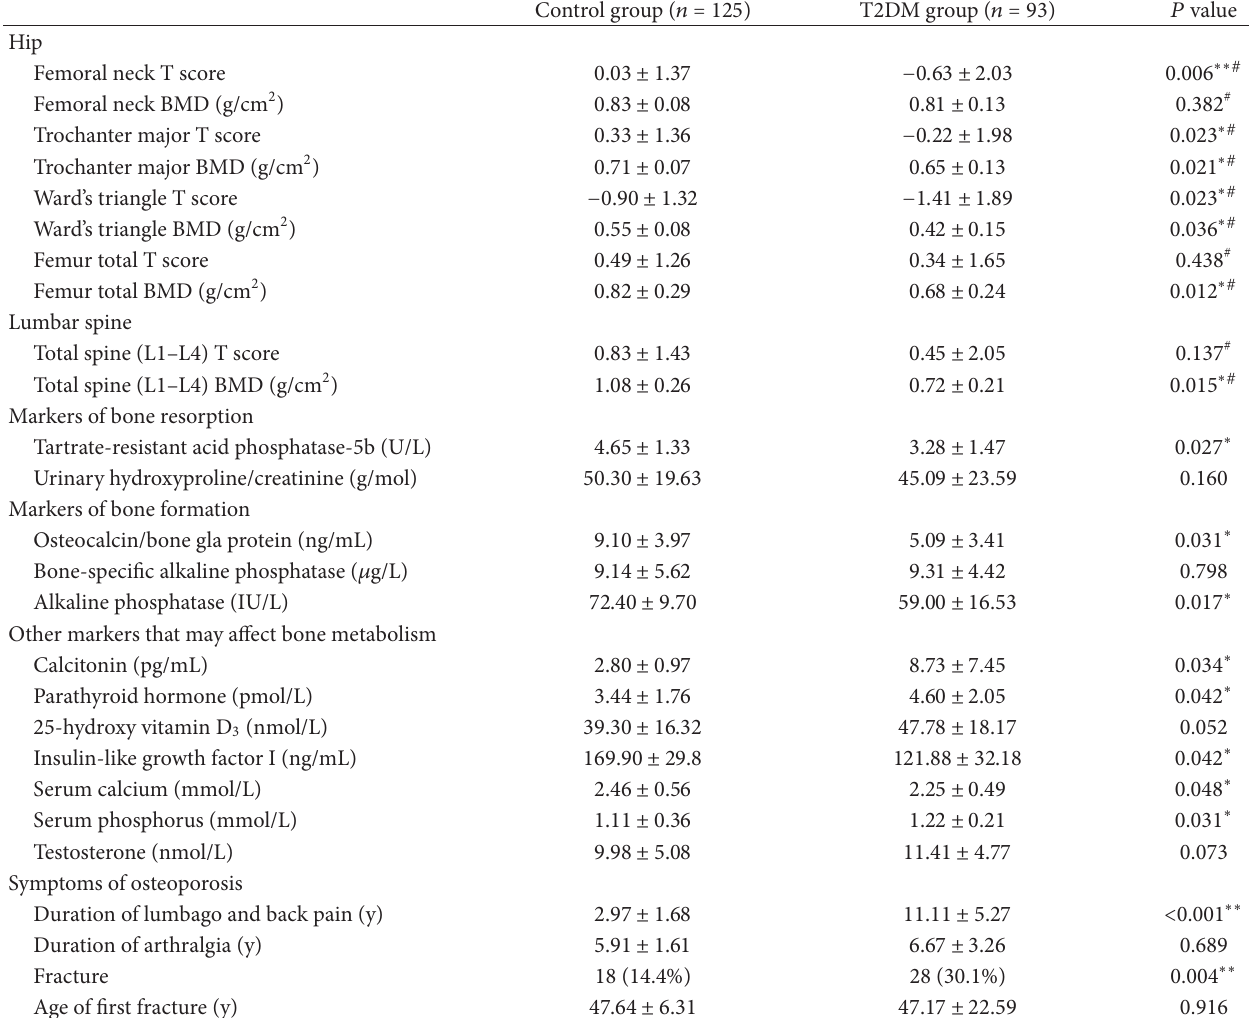
T 3: Effects of T2DM on bone mineral density and bone